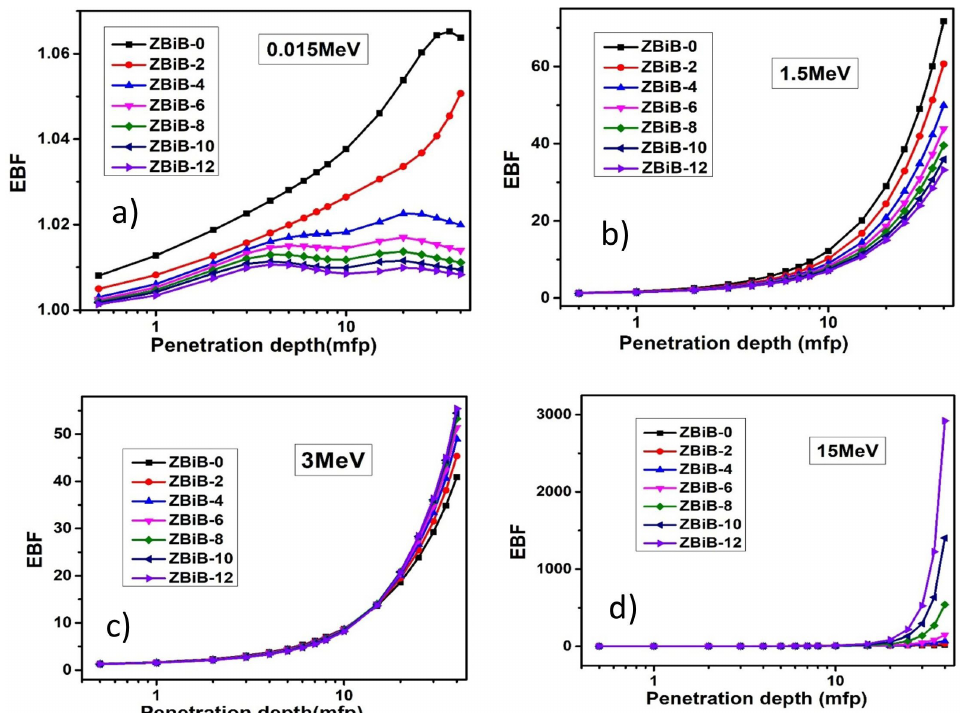
Figure 8. Variation of EBF values of fabricated glass samples with the penetration depth for 0.015, 1.5, 3 and 15 MeV